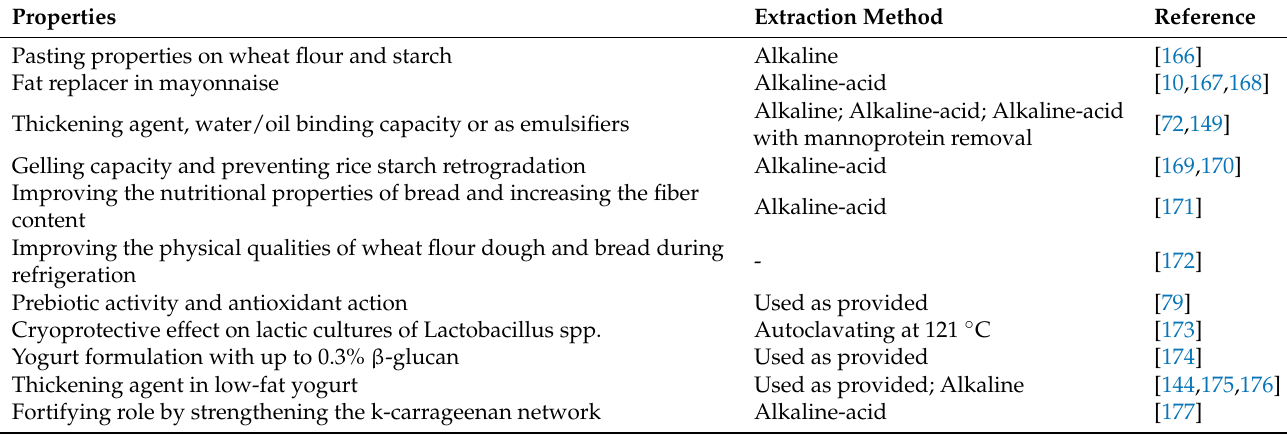
Table 2. The use of β -glucans from spent brewer’s yeast in food